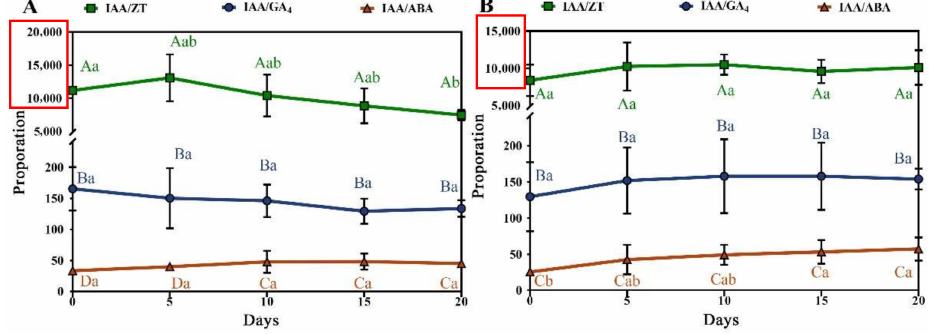
Figure 4. The changes of endogenous hormone proportion in A. praecox root tips and segments during callus induction. ( A ): Root tip; ( B ): Root segments. The different letters indicate significant differences at 5% level by Duncan’s range